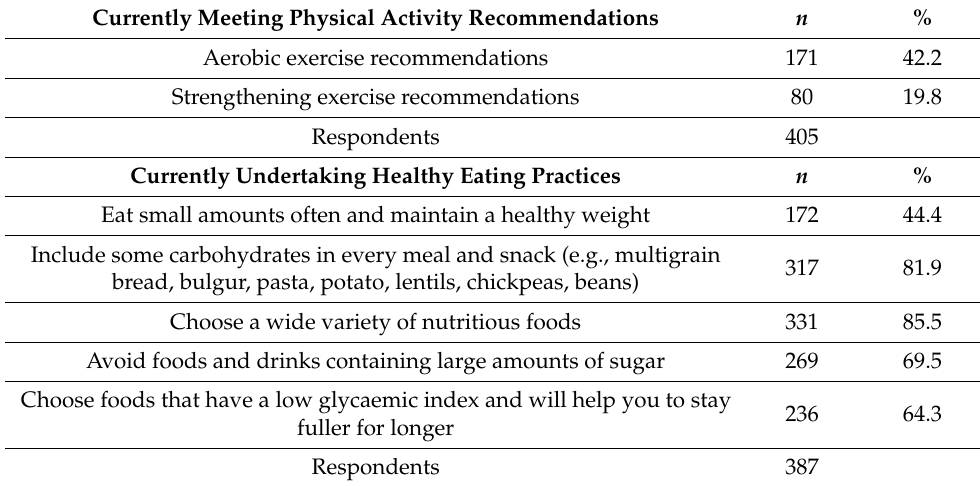
Table 2. Responses to meeting the physical activity and diet recommendations for